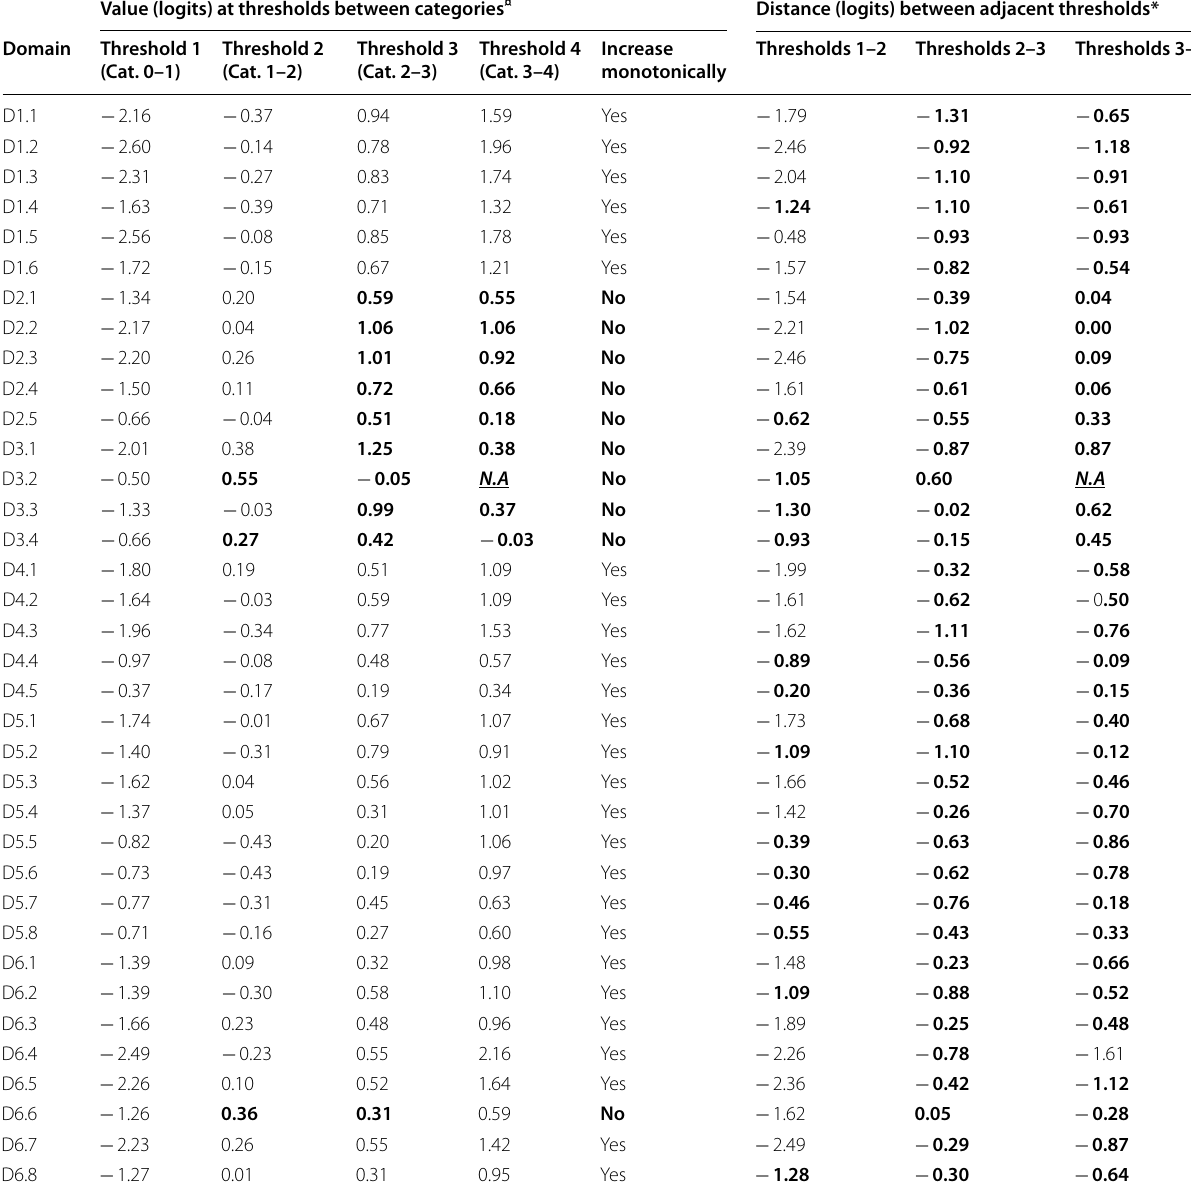
Table 4 Rating scale category structure for all items of the Swedish WHODAS